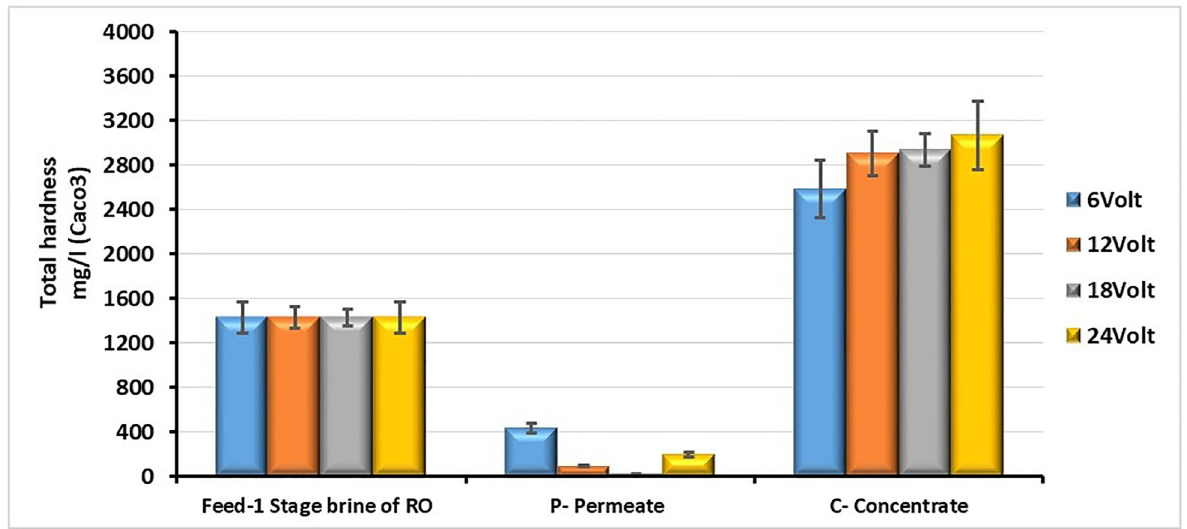
Fig 4. Comparison of the hardness of the feed brine, the desalinated water and the concentrated brine at different voltages (feed flow rate = 12 L/h, water recovery ratio for TDS 6764 mg/L = 75% and feed temperature = 14˚C).